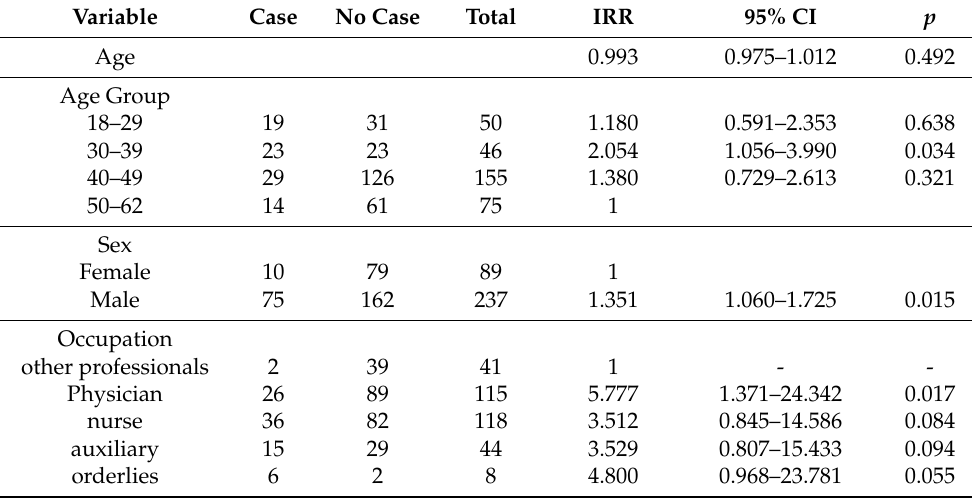
Table 2. Univariate Exact Poisson regression of secondary transmission by personal characteristics of index cases.